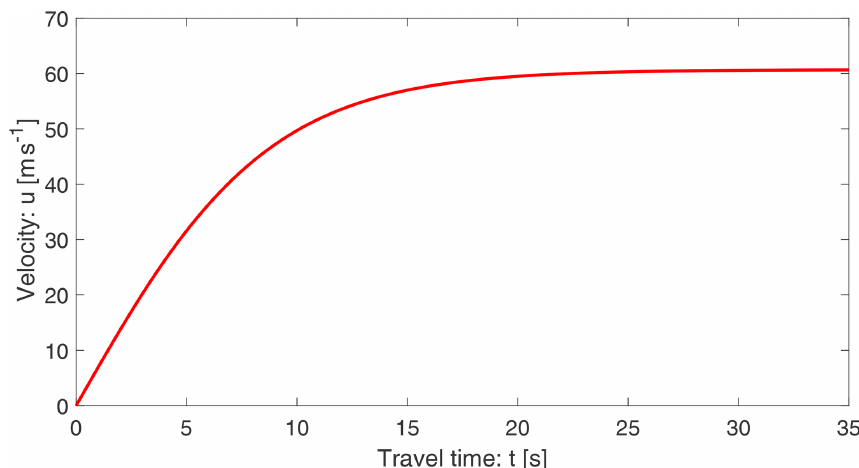
Figure 2. Time evolution of the landslide velocity down the slope with drag given by Eq. (11). The motion attains terminal velocity at about t =